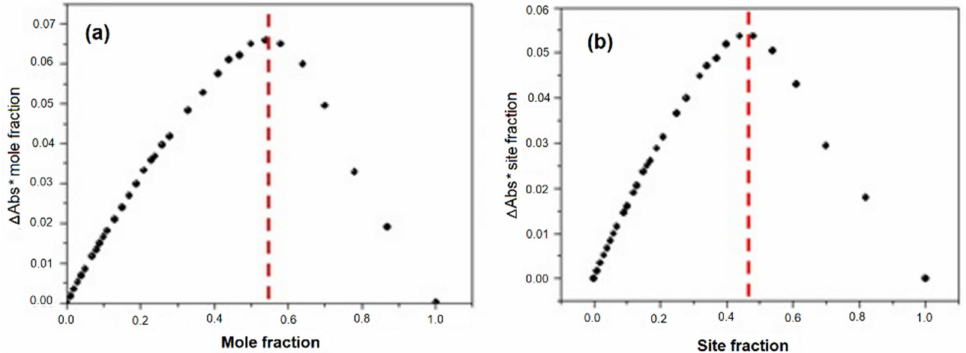
Figure 4. Job’s plots for the UV-vis titration of Zn-trisporphyrin 1 with DPYP in toluene ( c = 1 µ M). ( a ) mole fraction, and ( b ) site